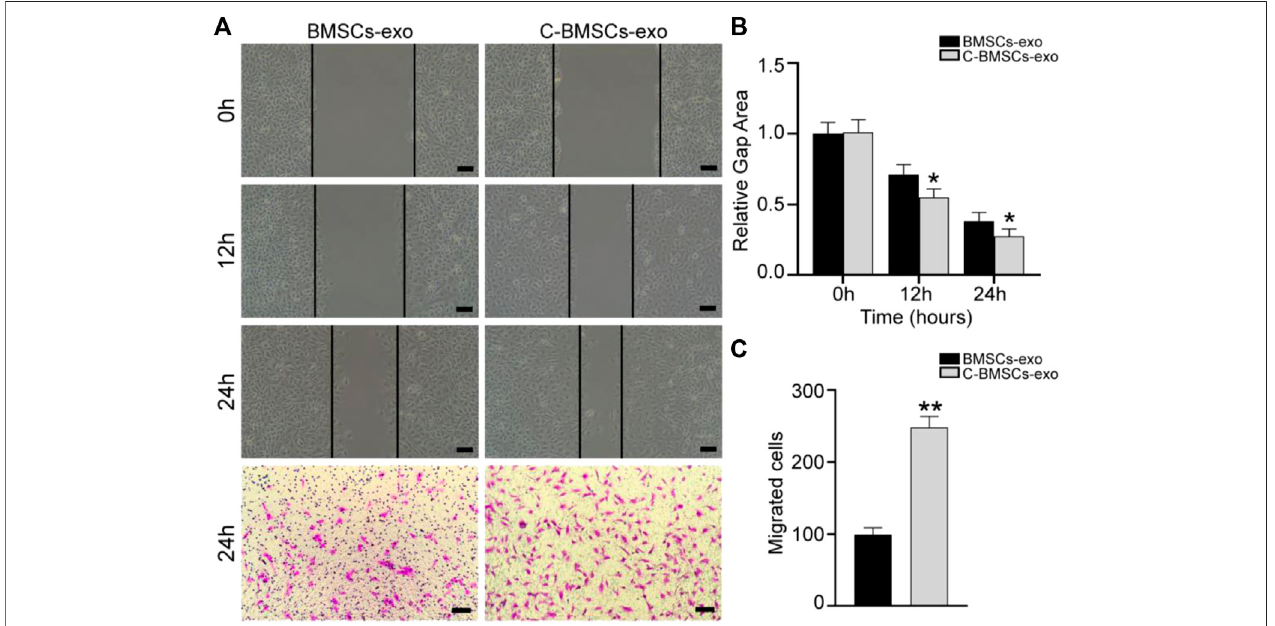
FIGURE3| C-BMSCs-exo treatment altersHUVECmigration. (A) RepresentativewoundhealingandTranswellassayresultsfollowingculturefor24 h. (B) Wound healing assays revealed signi fi cantly enhanced wound healing in the C-BMSC-exo group relative to the BMSC-exo group ( n = 3). (C) Transwell assays revealed signi fi cantly more migrator cells in the C-BMSC-exo group relative to the BMSC-exo group ( n = 3). * p < 0.05, Scale bar = 100 mm.